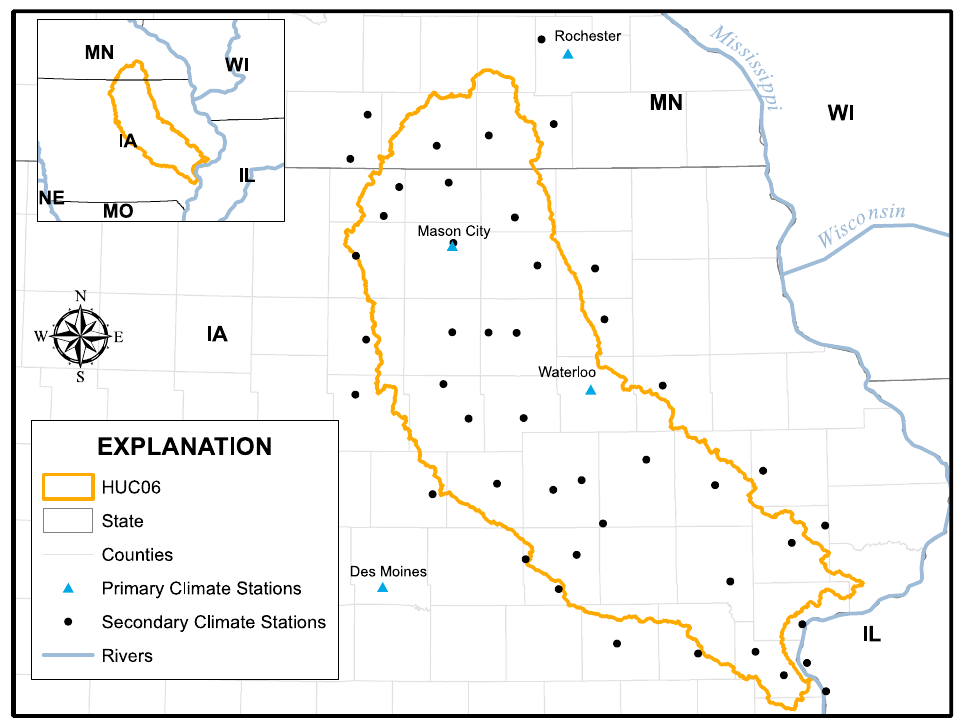
Figure 3. Selected basin (HUC06) for multi-scale assessment of nonpoint source pollution. The selected basin is characterized by the U.S. Geological Survey into hydrological units. Hydrological units vary in size and are successively divided into smaller hydrologic units. Each hydrological unit is represented by a unique hydrologic unit code (HUC). The study site corresponds to HUC06–070802. This HUC06 is further subdivided into 9 HUC08s (sub-basins), 82 HUC10s (watersheds), and 366 HUC12s (sub-watersheds). Each HUC12 constituted an AnnAGNPS simulation and therefore, the 366 HUC12s were further subdivided into 469,628 AnnAGNPS cells, representing field/sub-catchment scale (Figure 4). Results were calculated at sub-catchment scale and aggregated into sub-watershed, watershed, and sub-basin scale, demonstrating the multi-scale analysis potential of the ITEAMS simulation process (Figure 4).